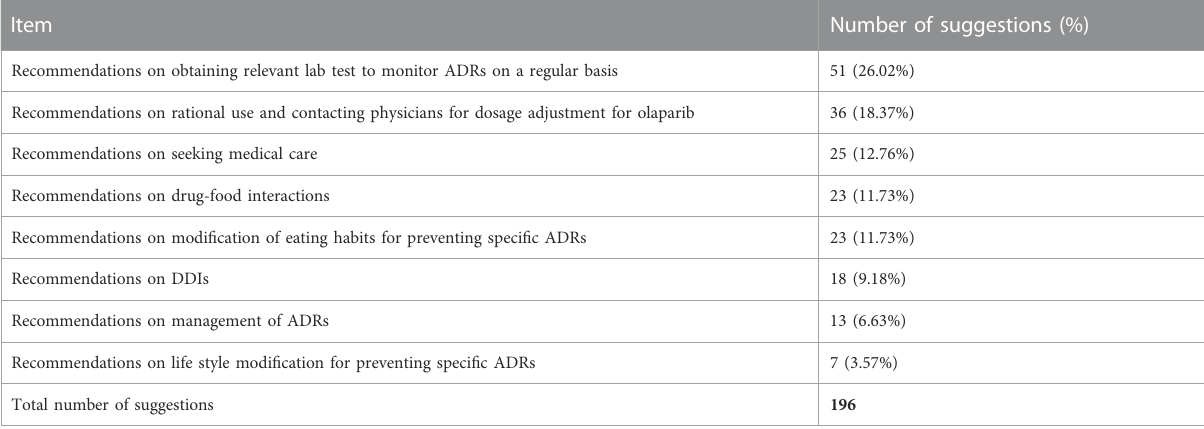
TABLE 6 Suggestions made by the pharmacists.